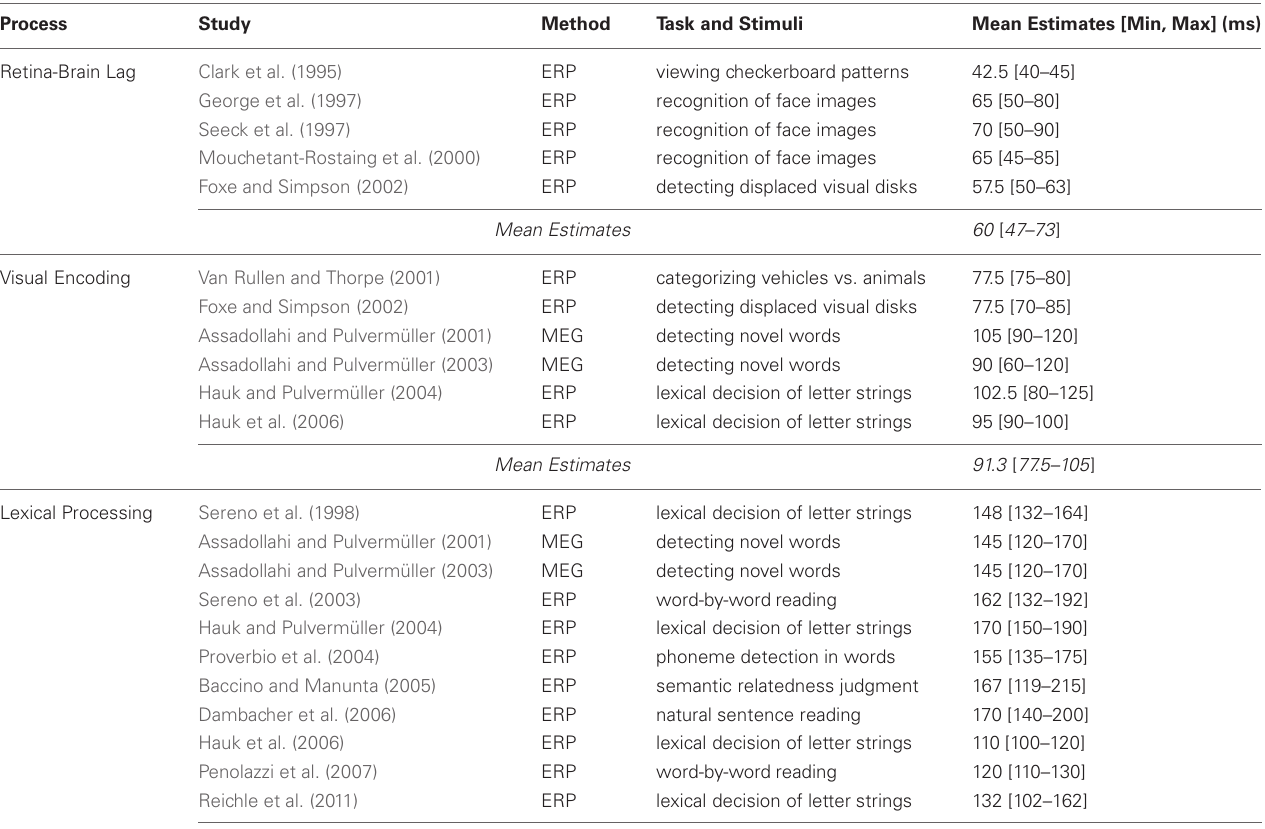
Table 1 | Studies (listed chronologically) examining the time course the retina-brain lag, visual encoding, and lexical processing, including their method, task and stimuli, and estimates (in ms) of when the processes occur.